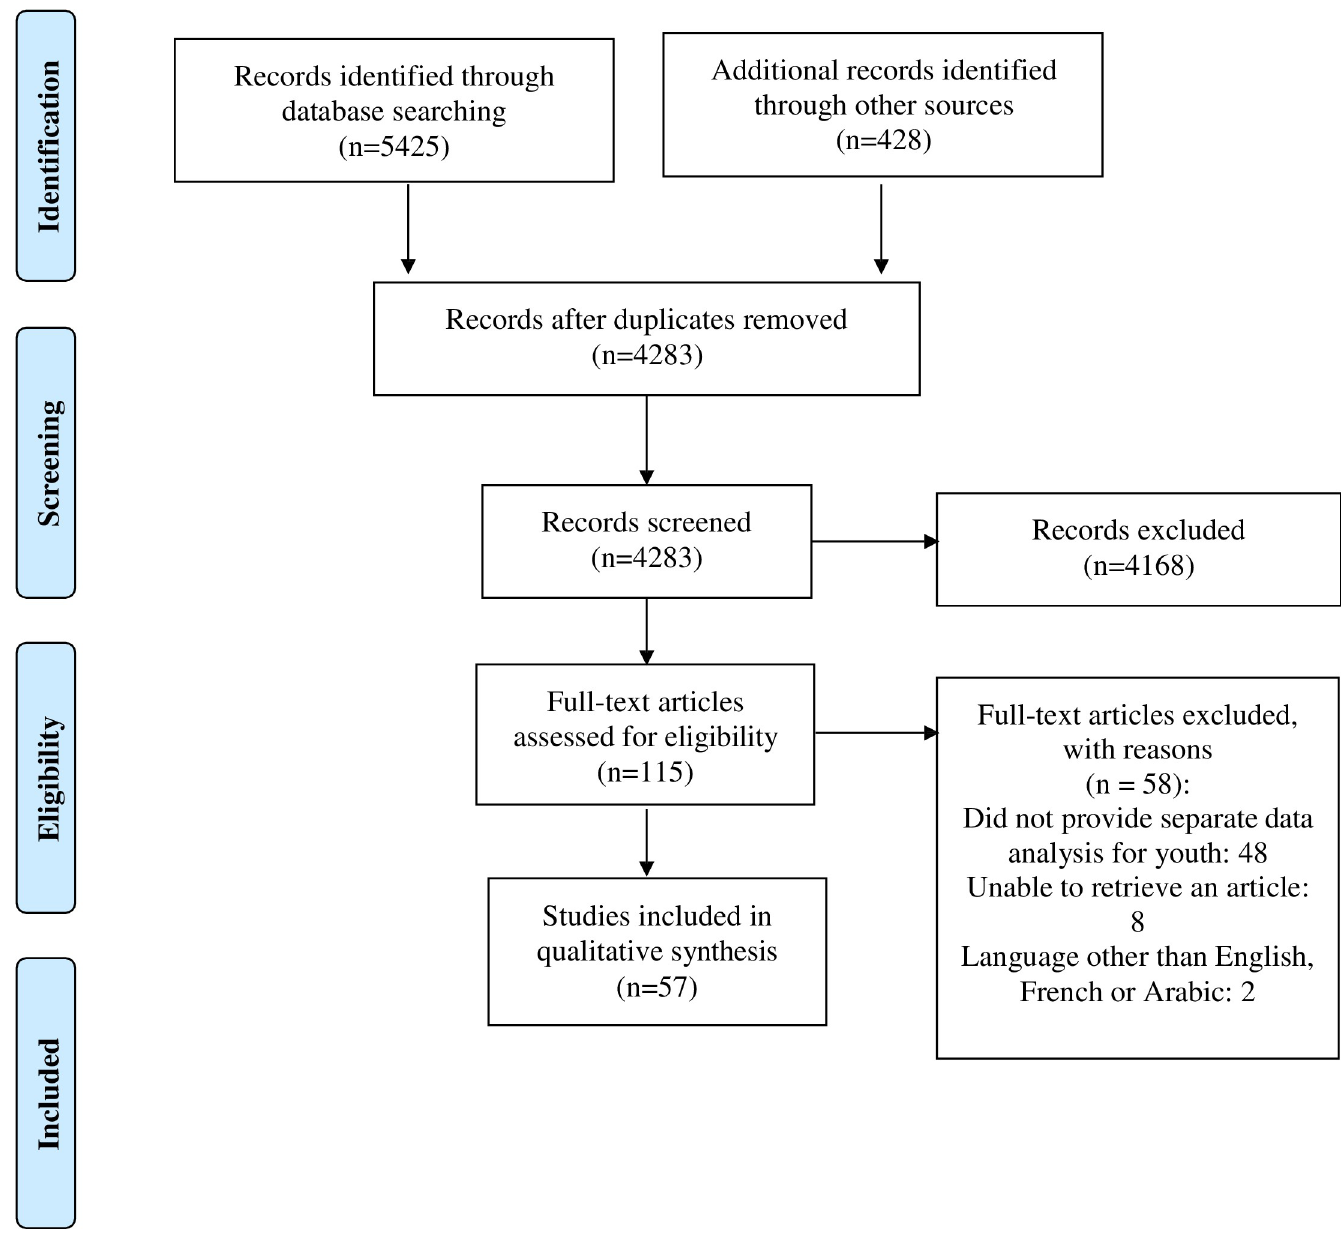
Fig 1. PRISMA flow